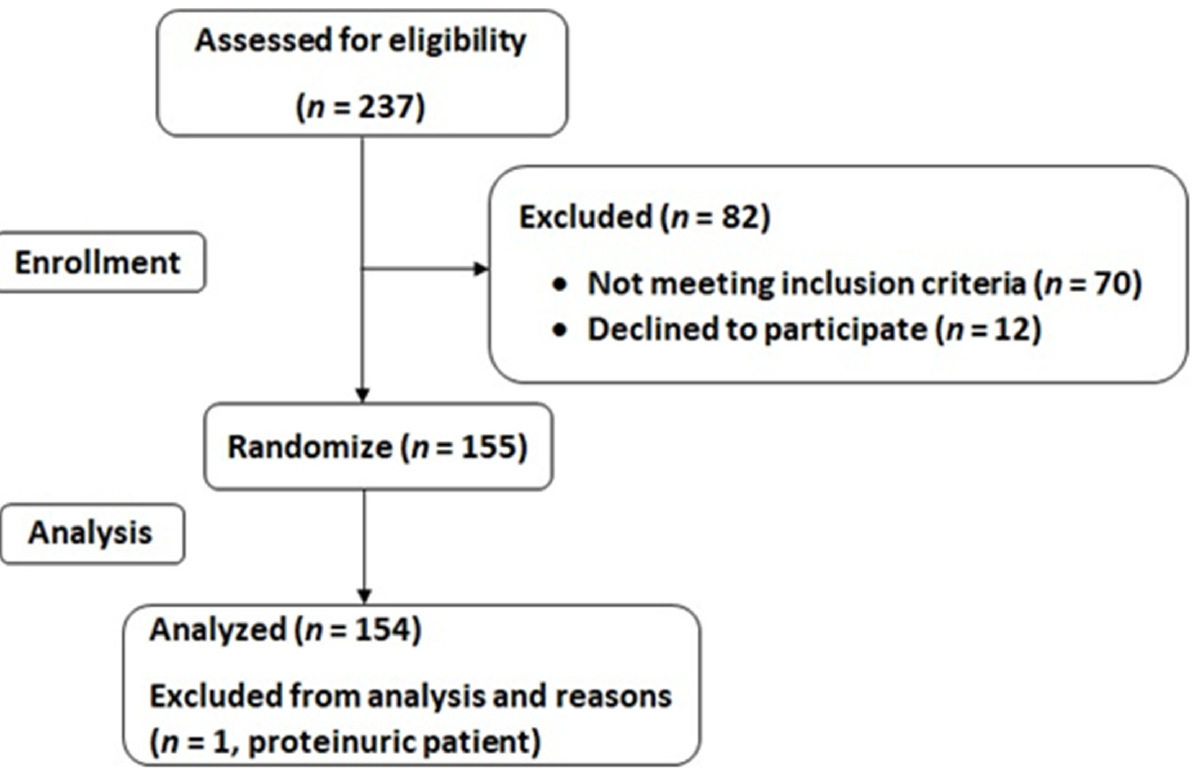
Figure 1. Study flow-chart.